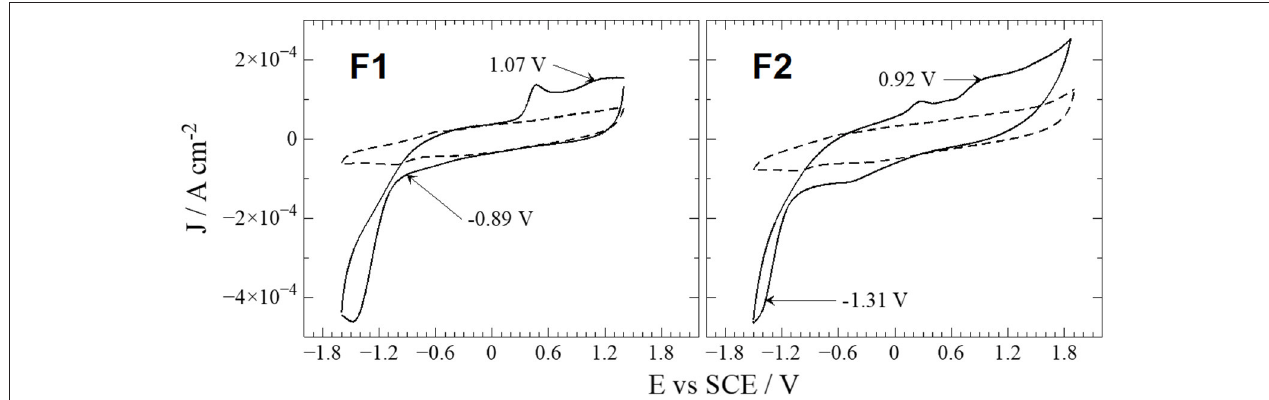
FIGURE 3 | CV profiles of F1 , F2 (straight lines) and blank (dashed lines). Interphase: Pt| 0.01mol L − 1 of compound + 0.1mol L − 1 of TBAPF 6 in anhydrous CH 3 CN under an argon atmosphere. Scan rate: 200mV s − 1 .